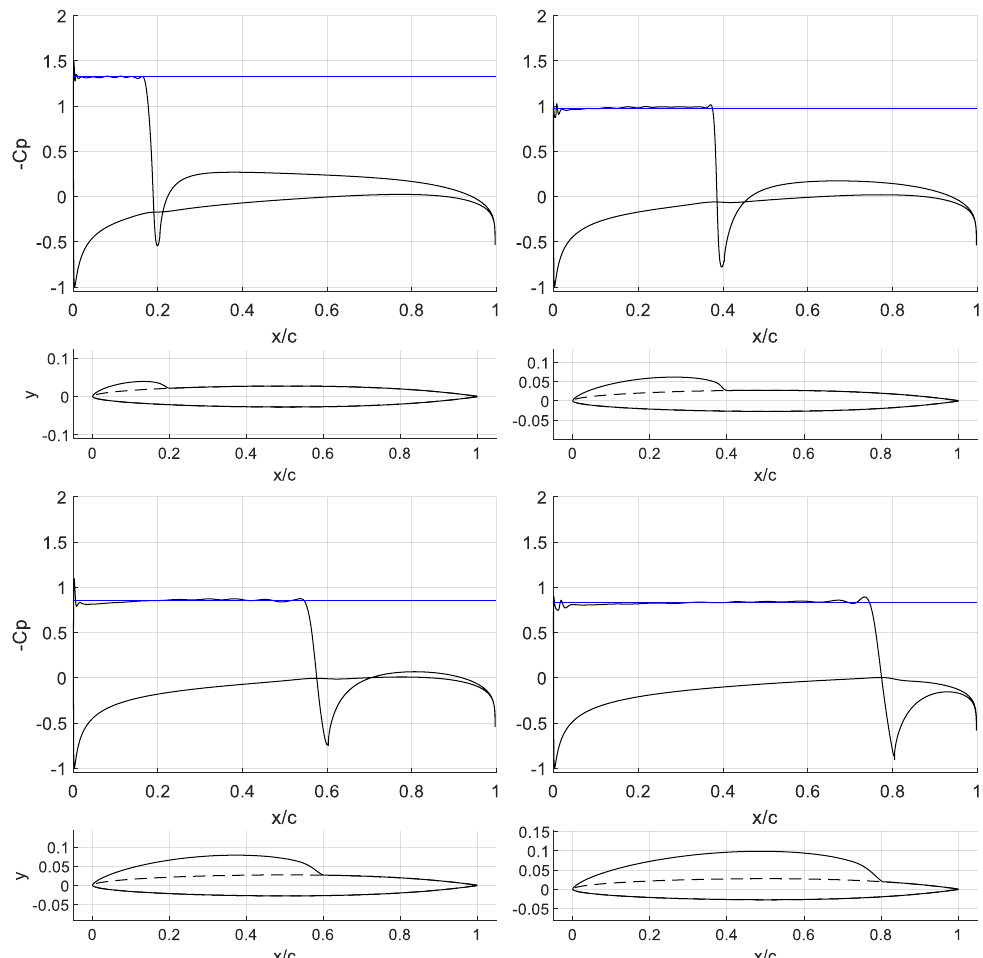
Figure 10. Predicted pressure profiles and cavity shapes for a NACA 16–006 hydrofoil at a = 4 ◦ using the present method for cavity length in the range of l c = { 0.2, 0.4, 0.6, 0.8 } . The dashed line shows the non-cavitating hydrofoil.